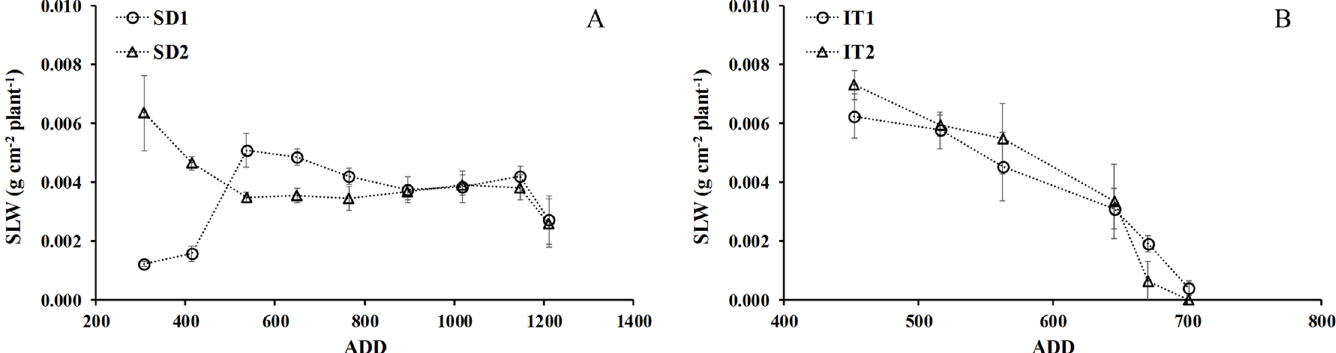
Fig 8. Mean specific leaf area (SLW) per plant as a function of accumulated thermal time (ADD), showing both treatments from sowing to harvest for sowing date (A) and water availability (B) in chia plants established in Antumapu and Intihuasi (x± SD n = 12).